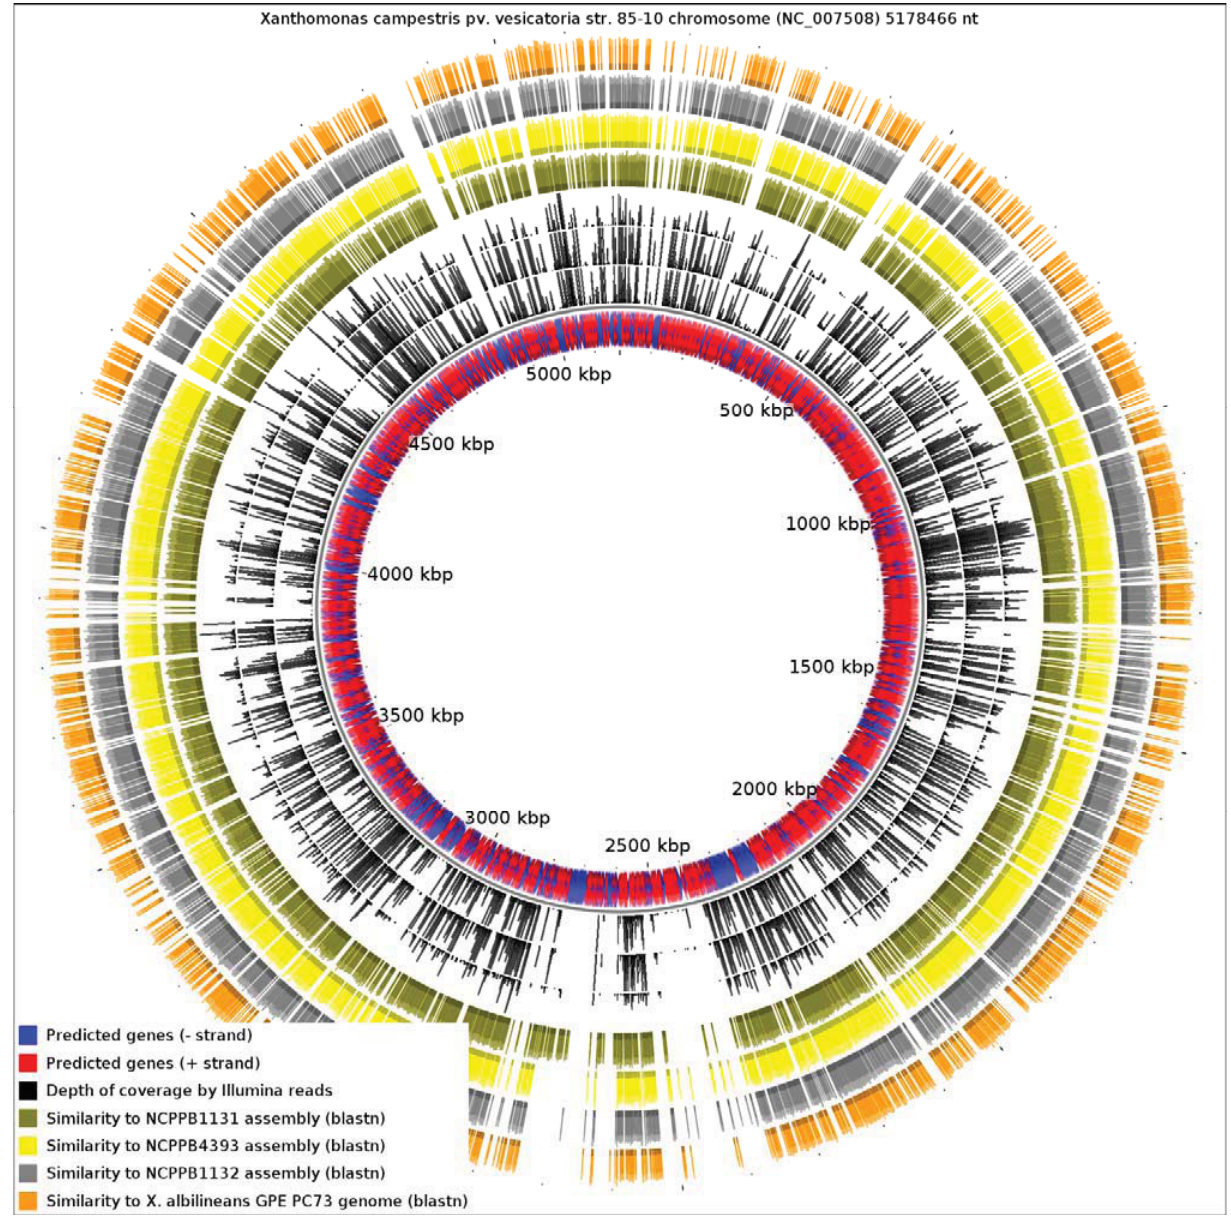
Figure 4. Alignment of the four Xanthomonas Group 1 genome sequences against the chromosome of Xanthomonas campestris pv. vesicatoria . The blue and red inner track represents annotated genes. The next three black tracks represent depth of coverage by Illumina sequence reads for NCPPB1131, NCPPB4393 and NCPPB1131 respectively. The four colored outer rings indicate sequence similarity to the genome assemblies of NCPPB1131 (olive), NCPPB4393 (yellow), NCPPB1131 (grey) and X. albilineans (orange)